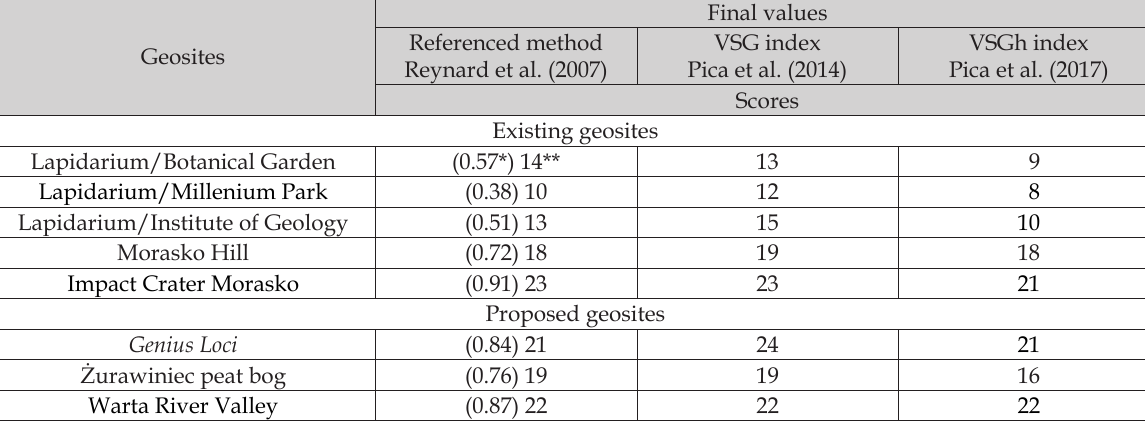
Table 2. Comparison of assessments for existing and proposed urban geosites in Poznań obtained from three methods by different authors.